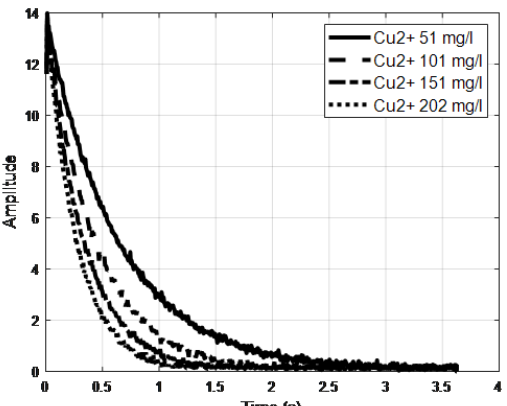
Figure 2: Four transverse magnetization decays of samples with Cu 2+